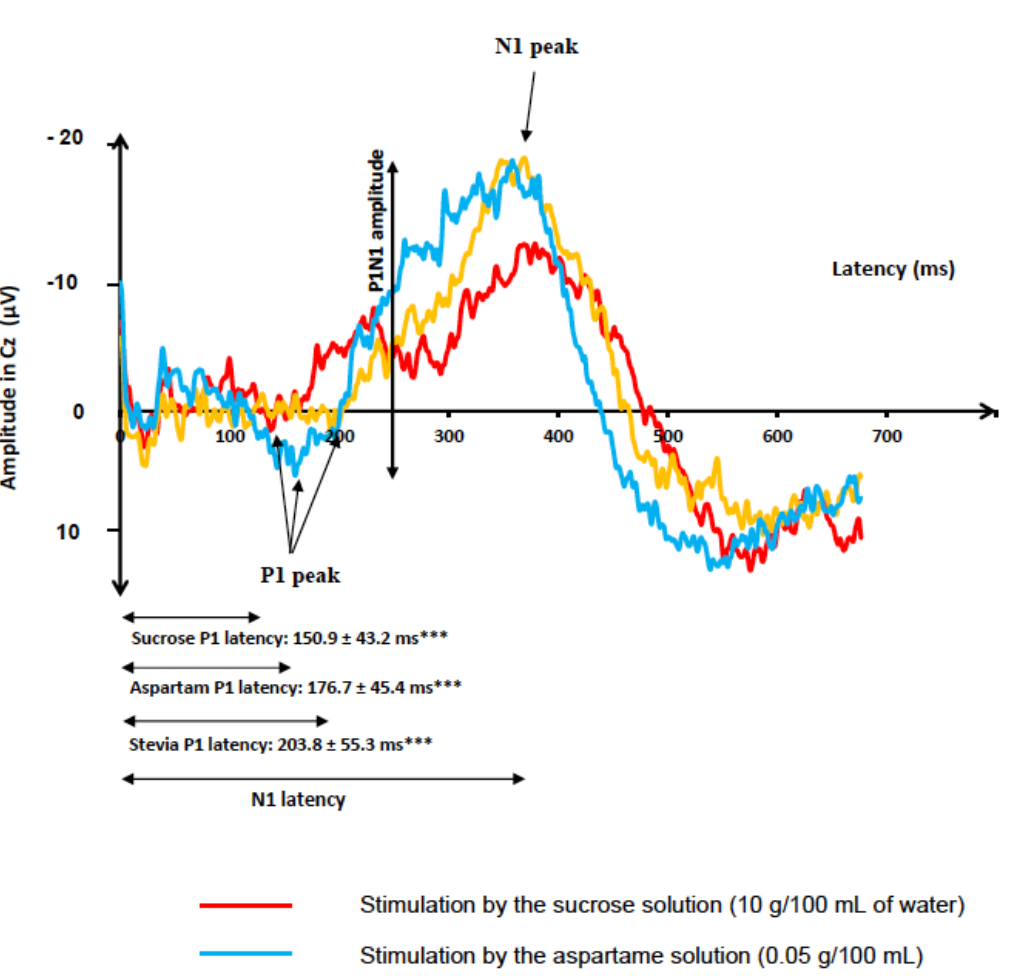
Figure 1. Grand average (average of the responses of all subjects) of gustatory-evoked potentials (GEPs): Recordings of GEPs in response to the three sweet solutions (sucrose, aspartame, and Stevia) at the Cz electrodes, for all the 20 participants. GEP was defined by three peaks: P1, the first positive peak; N1, the higher negative peak; and P2, the second positive peak. The start of the taste stimulation was at 0 ms. P1 latencies were significantly di ff erent between the three taste stimuli in GEPs recorded at Cz. *** indicates p < 0.001 for the global statistical model comparing P1 latencies of GEPs in Cz between the three solutions (Friedman test on ranks).